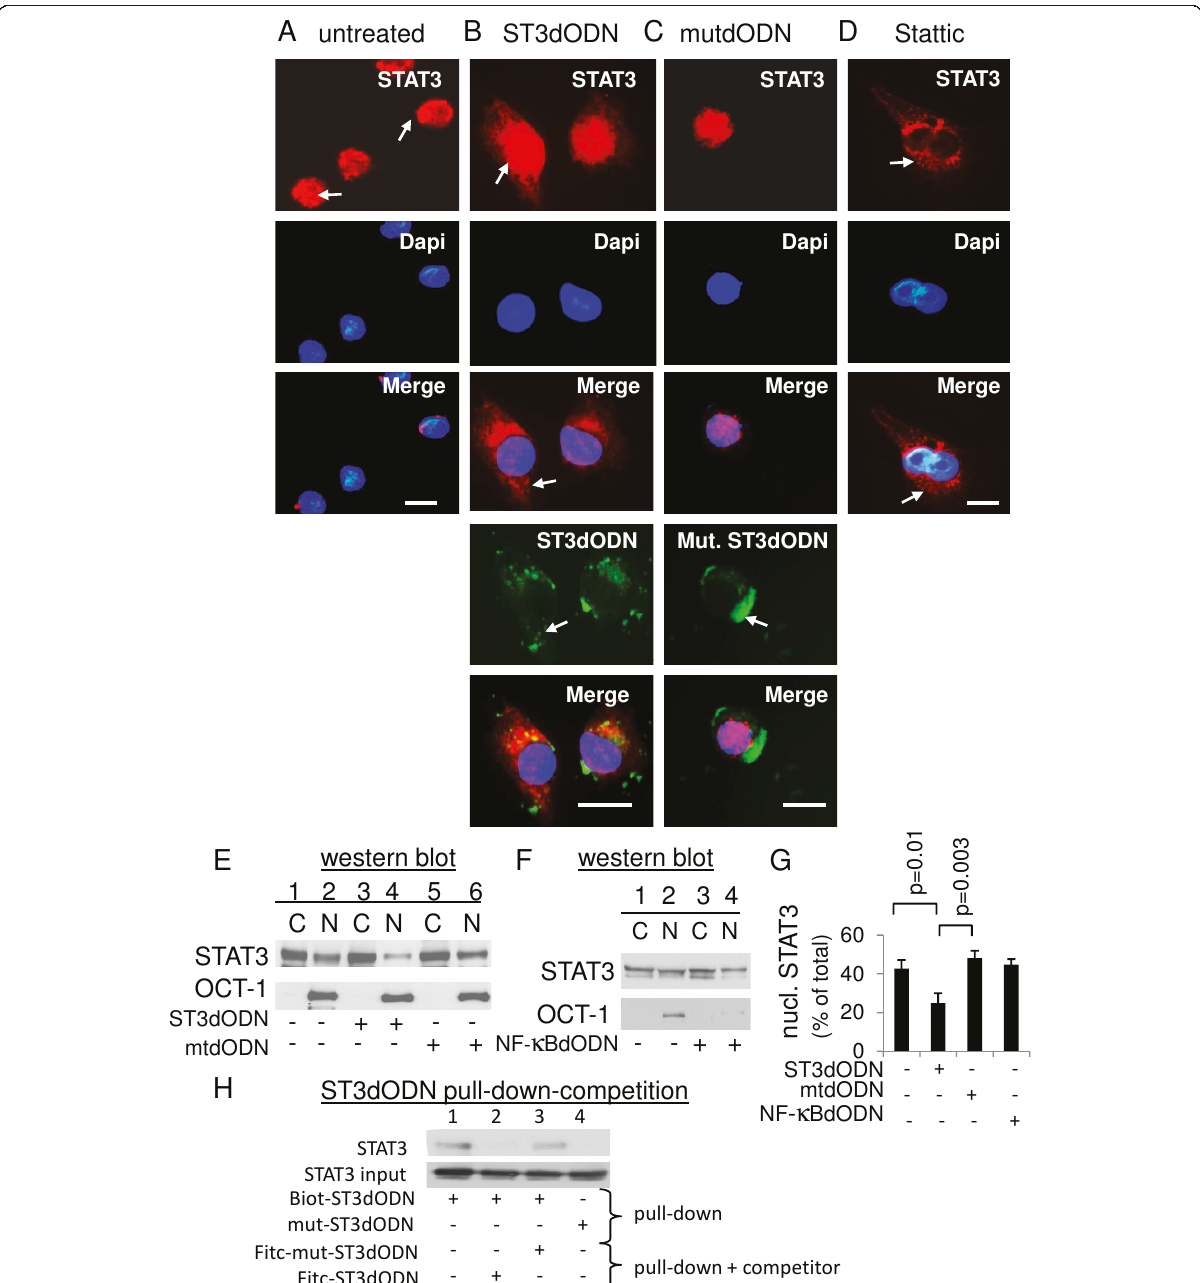
Figure 3 Inhibition of STAT3 nuclear localization by STAT3-decoy ODN . A : Nuclear localization of STAT3 (red) in non-treated SW 480 cells. Cells were fixed and labelled with anti-STAT3 antibody; B : cytoplasmic localization of STAT3 (red) in STAT3-decoy ODN- transfected (2 μ g/ml) SW480 cells; FITC-labeled STAT3-decoy ODN was detected in the cytoplasm (green); C : nuclear localization of STAT3 (red) in mutated STAT3- ODN- transfected (2 μ g/ml) SW480 cells; FITC-labeled mutated STAT3-ODN was detected in the cytoplasm (green); D : cytoplasmic localization of STAT3 in Stattic-treated cells (20 μ M). Nuclei stained with DAPI. Scale: 10 nm. E : Cells transfected with STAT3-decoy ODN and STAT3 determined in cytoplasm and nucleus: no treatment (1 and 2), STAT3-decoy ODN 2 μ g/ml (3 and 4), mutated STAT3-decoy ODN (mtODN) 2 μ g/ml (5 and 6). OCT-1 antibody reprobing to check for cytoplasmic contamination. A typical result is shown. F : Cells were untreated (1 and 2), transfected with decoy NF- (cid:1) B-ODN (2 μ g/ml) (3 and 4), and STAT3 subcellular localization determined. G : Quantitative comparison. In control and mutated STAT3-decoy ODN (mtODN)- or decoy NF- (cid:1) B-ODN-transfected cells, nuclear STAT3 (expressed as % of total STAT3, cytoplasmic + nuclear) was 50%; it was below 20% in STAT3-decoy ODN-transfected cells. Data from at least three independent experiments. A t test was used to calculate p values, n>3. H : Cells transfected with biotinylated STAT3-decoy ODN (1, 2 and 3) or its mutated equivalent (4) and complexes recovered and analyzed as in D; cells co-transfected with competitor: non-biotinylated STAT3-decoy ODN (2) or its mutated equivalent